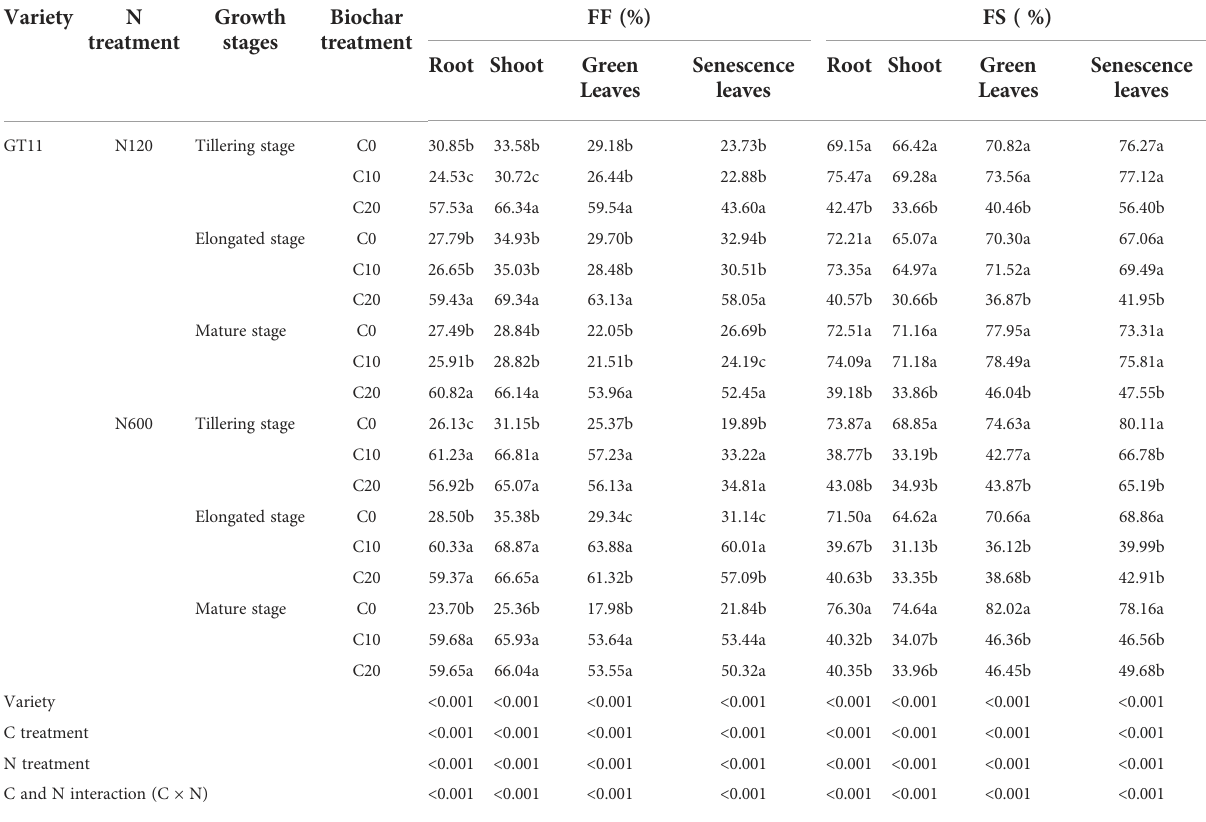
TABLE 3A Effects of biochar and N fertilizer treatment on FF and FS of GT11. Variety N